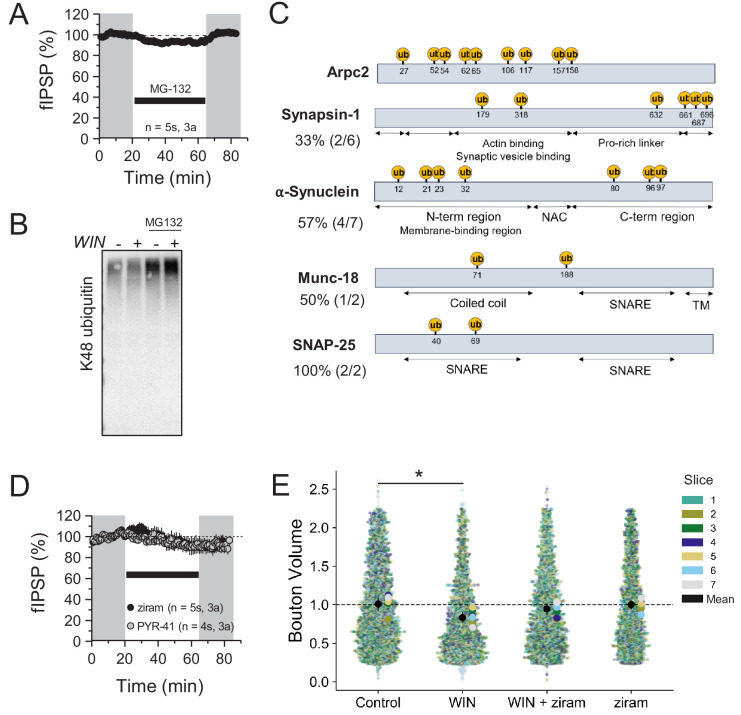
CB1-iLTD results in changes in proteins with ubiquitination sites in functional domains.(A) MG-132 (5 µM) did not cause a change in baseline transmission upon washout. MG-132: 99.66 ± 2.43%; p>0.05, one sample t-test. For all electrophysiology figures, averaged summary data expressed as normalized change from baseline ± S.E.M. and n = number of slices (s), number of animals (a). (B) Western blot of accumulated K48 ubiquitinated proteins when proteasome is blocked with 5 µM MG-132 demonstrated the efficacy of the drug. (C) Predicted ubiquitination sites based on protein sequence plotted with UbiSite. Percentage represents # of predicted Ub sites in functional domains of protein divided by total predicted sites. Note: no protein structure data was available for Arpc2. NAC: non-amyloid component region of α-synuclein. SNARE: SNARE protein interaction site. TM: transmembrane domain. (D) Ziram (25 µM) or PYR-41 (50 µM) did not cause a significant change in baseline transmission. ziram: 91.56 ± 6.49%; p>0.05, one sample t-test. PYR-41: 91.49 ± 4.0; p>0.05, one sample t-test. (E) Quantification of normalized CB1 bouton volume by slice. Superplot shows individual bouton volume values color-coded by slice in swarmplot with solid larger dots overlaid representing mean bouton volume per slice. Overall mean of each slice is given by solid black circle with 95% CI represented by the vertical black line. Control: 1.00 ± 0.05 vs. WIN: 0.83 ± 0.03 vs. WIN + ziram: 0.95 ± 0.04 vs. ziram: 1.00 ± 0.03 (Mean ± S.E.M.); F[3,24]=4.87, p=0.009, one-way ANOVA with post-hoc Tukey test for multiple comparisons. WIN vs. Control: CI [−0.32,–0.032], p=0.013, WIN vs. Control: CI[−0.32,–0.032], p=0.013, ziram vs. WIN: CI[0.03, 0.31], p=0.02. n = number of slices (three images/slice, one slice/rat, seven rats/condition). 95% Confidence intervals (CI) are given as CI[lower CI, upper CI]. p-Values are exact.